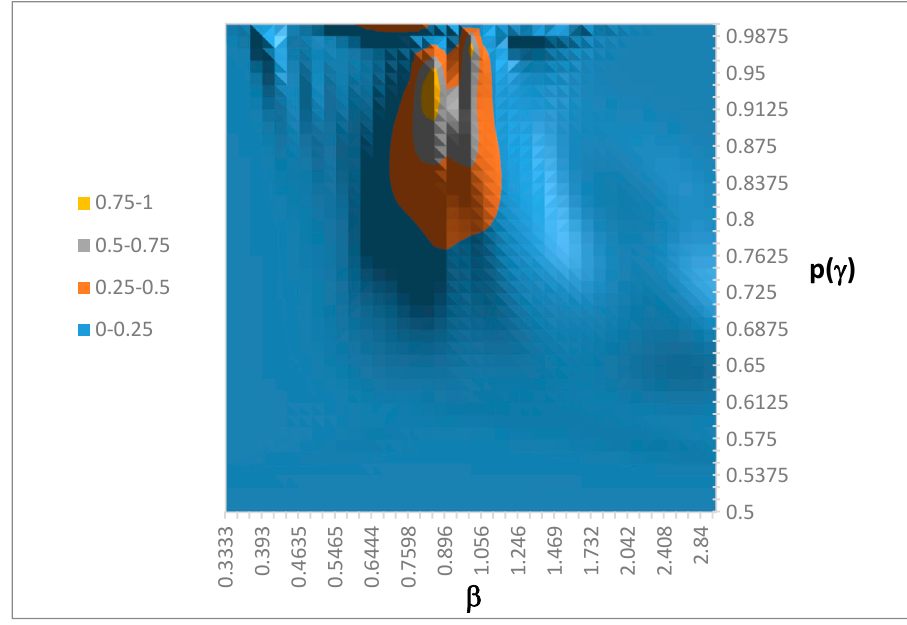
Figure 2. Marginal of g* on (p( γ ), β ).